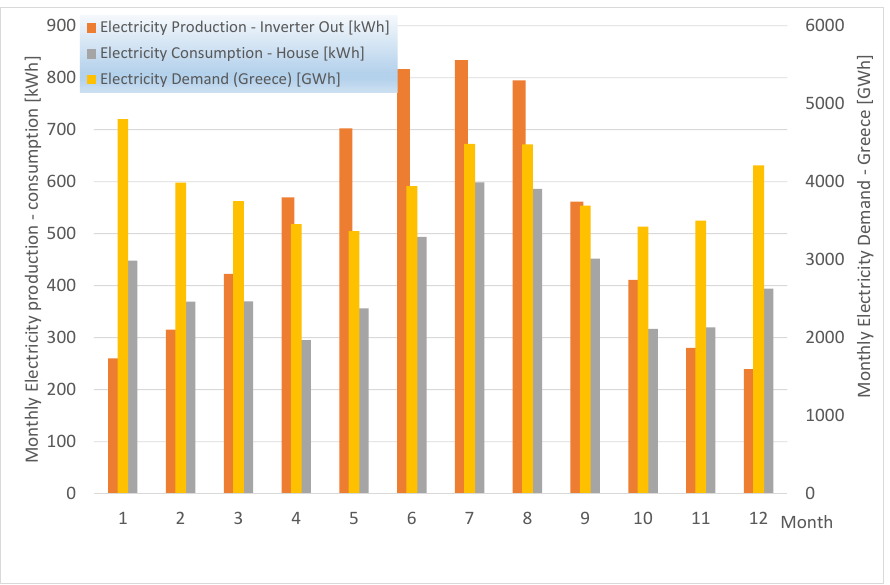
Figure 9. Monthly electricity production (kWh) of the house’s PV installation with 16 panels. For comparison, the house’s monthly electricity consumption and Greece electricity consumption (GWh) are shown in the same figure.